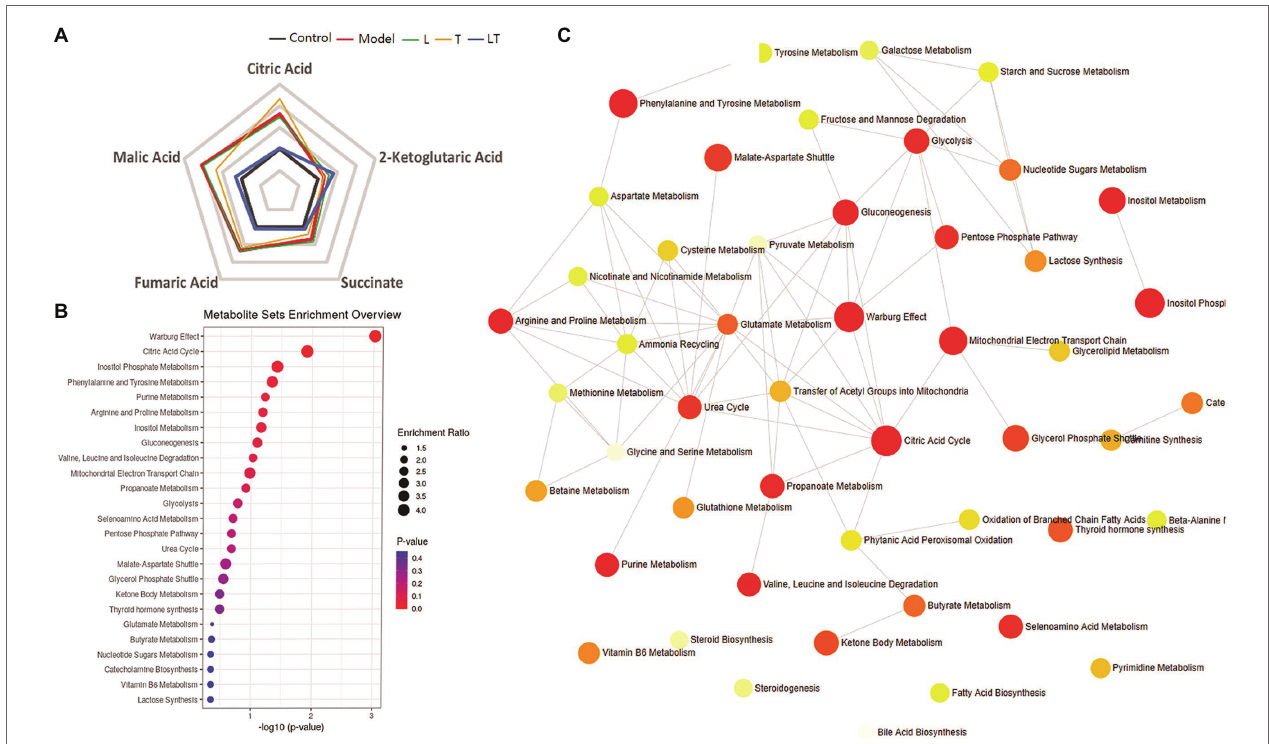
FIGURE 7 | The effect of the regulatory effect of l -carnitine combined with trimetazidine on five key molecules and primary metabolic pathways based on the metabolome of cardiac tissue. (A) A phase diagram for the five key molecules of cardiac tissue involved in glycolysis, tricarboxylic acid (TCA), and fatty